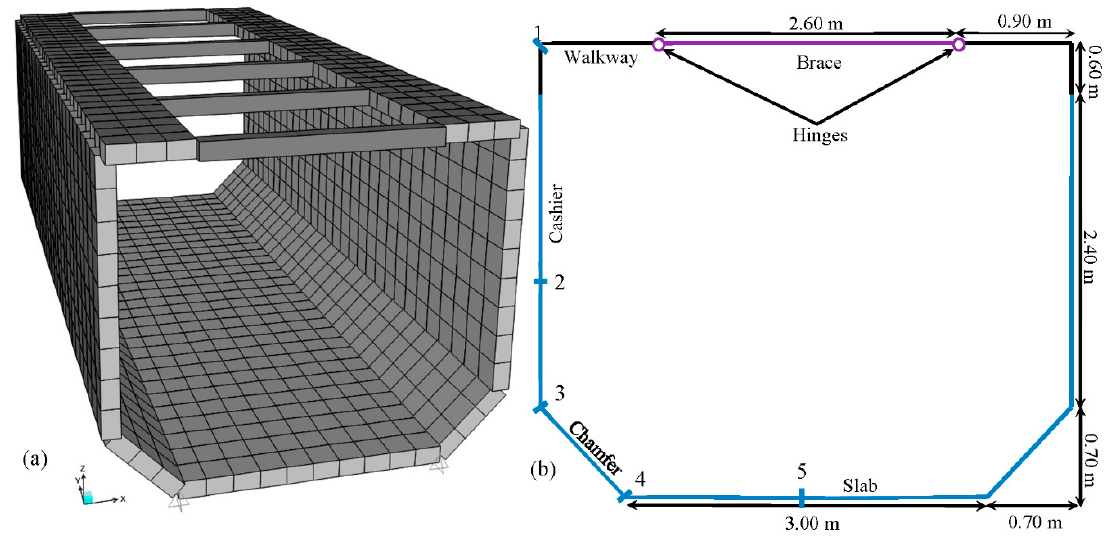
Figure 5. ( a ) 3D Finite element mesh of a 10.0 m length canal module and ( b ) control sections (1–5).